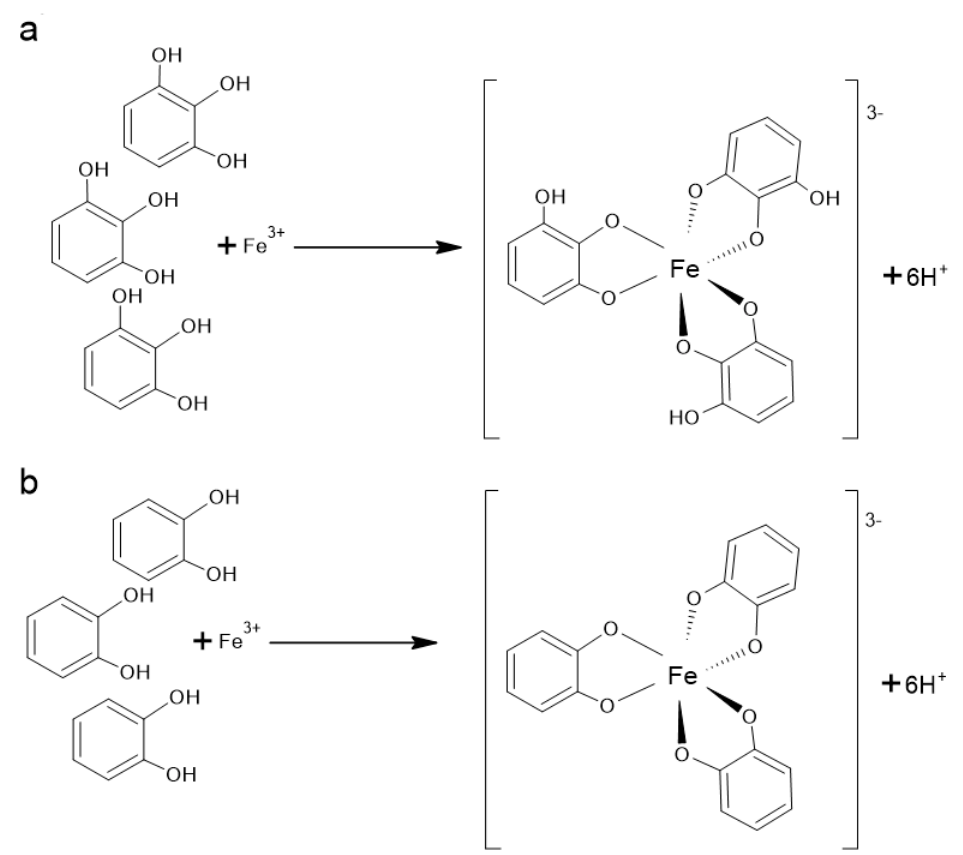
Figure 3. Expected octahedral coordination geometry of general iron-polyphenol complexes, ( a ) gallol, ( b ) catechols. Coordination requires deprotonation of the polyphenol ligands. Based on [201].